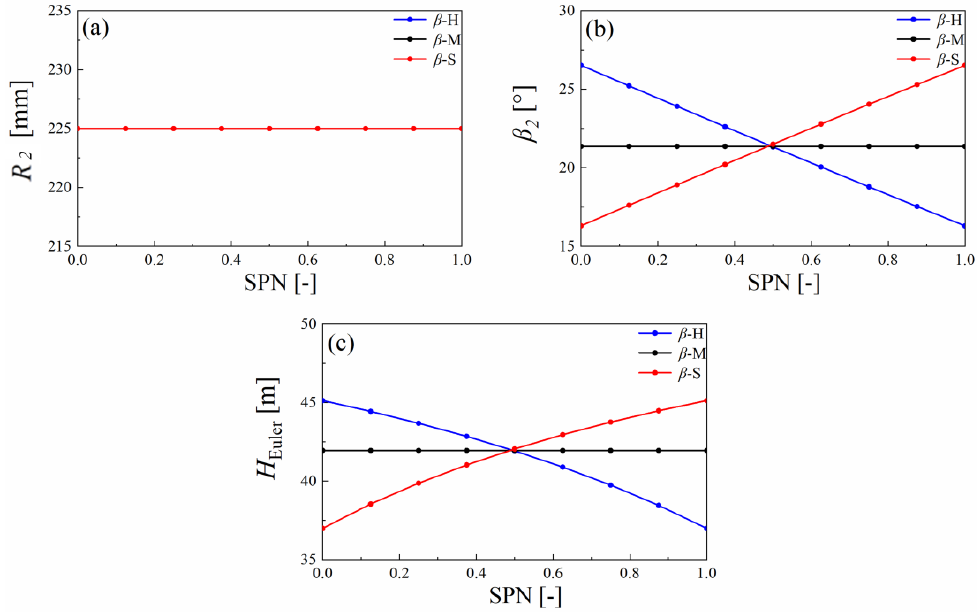
Figure 7. Distributions of design parameters in different runners along the spanwise direction: ( a ) R 2 , ( b ) β 2 , ( c ) H Euler